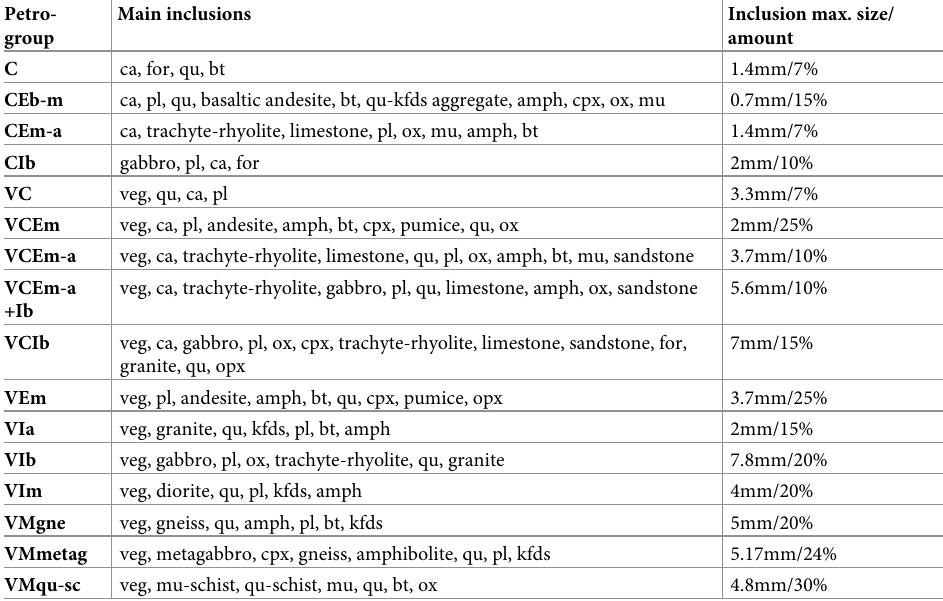
Table 3. Main features of the petro-groups considered in this